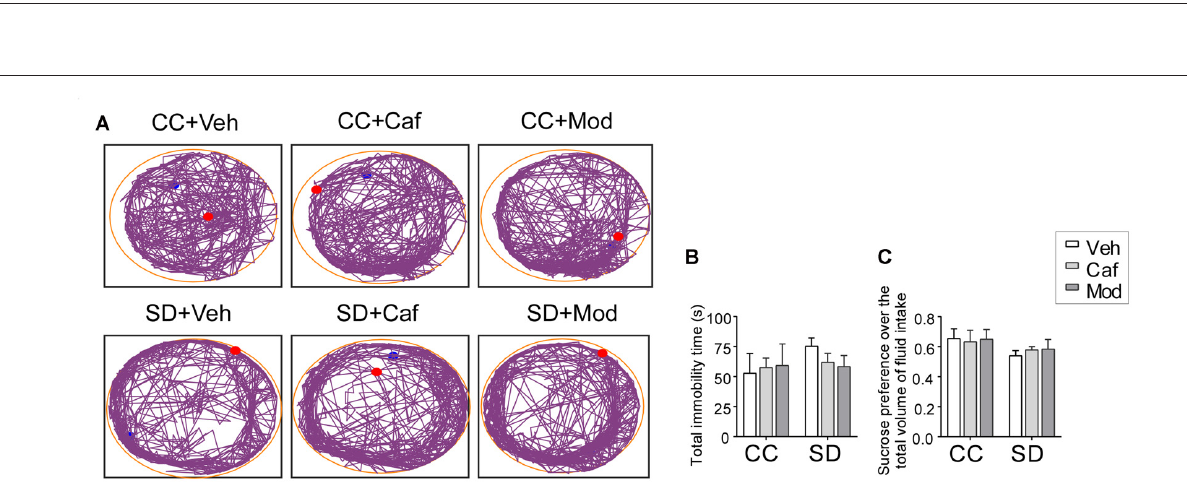
improved/increased the total distance traveled in the OF in SD exposed animals compared to sleep-deprived rats ( F ( 2,114 ) = 14.91; p = 0.0001; Figure 2E ). However, change in OF test was